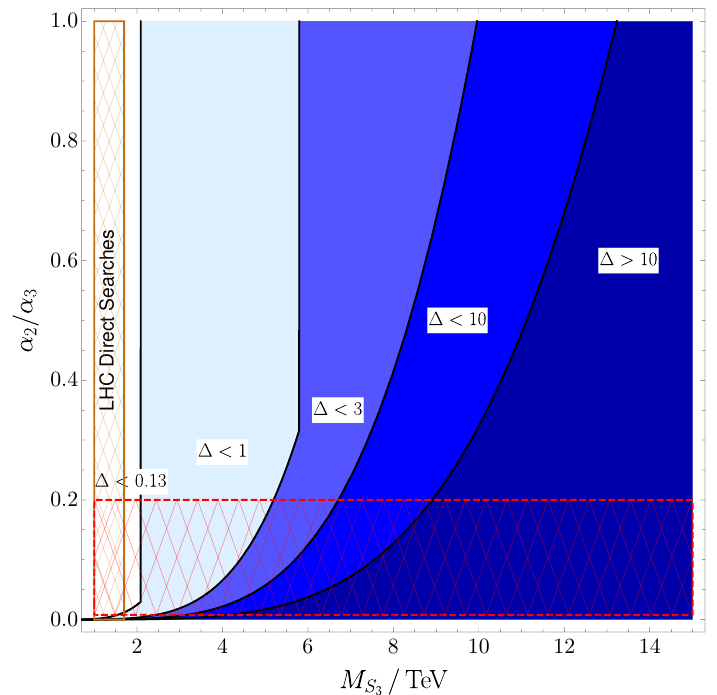
Figure 4 . Constraints on the ratio α 2 /α 3 vs. the leptoquark mass, with ∆ C µ fixed to the central value of the global fit [12] to B anomaly data. The brown hatched region ( M S ≤ 1 . 7 TeV) is excluded by ATLAS direct searches [70]. The constraint from B s meson mixing 3 is not visible on the plot, since at the best fit point for the anomalies it only imposes an upper bound of M S ≤ 55 TeV . The blue shaded regions indicate the degree of fine-tuning of the finite 3 Higgs mass corrections, with ∆ > 1 indicating that the finite loop corrections exceed 125 GeV. The region with ∆ ≤ 0 . 13 exhibits a similar degree of naturalness to the SM, for which only a sliver of parameter space remains compatible with direct searches. Finally, the red hatched region shows the U(2) -like region where α 2 /α 3 ∈ [0 . 2 , 5] V ts , which requires a tuning ∆ > 1 for M S